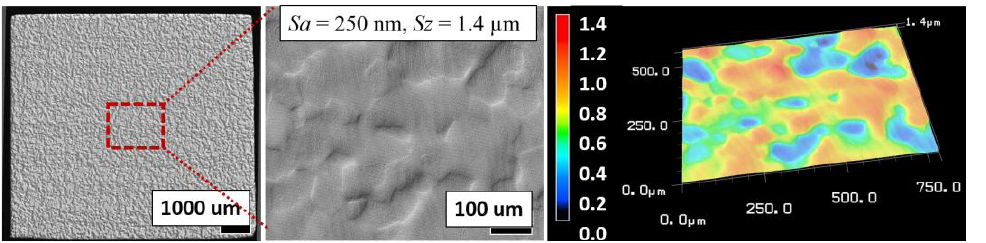
Figure 10. Identified particles from the laser confocal images (Figure 9) with edge-detection algo- rithms (OpenCV). Red circles correspond to locations there are embedded diamonds. Scale is de- fined in pixels.